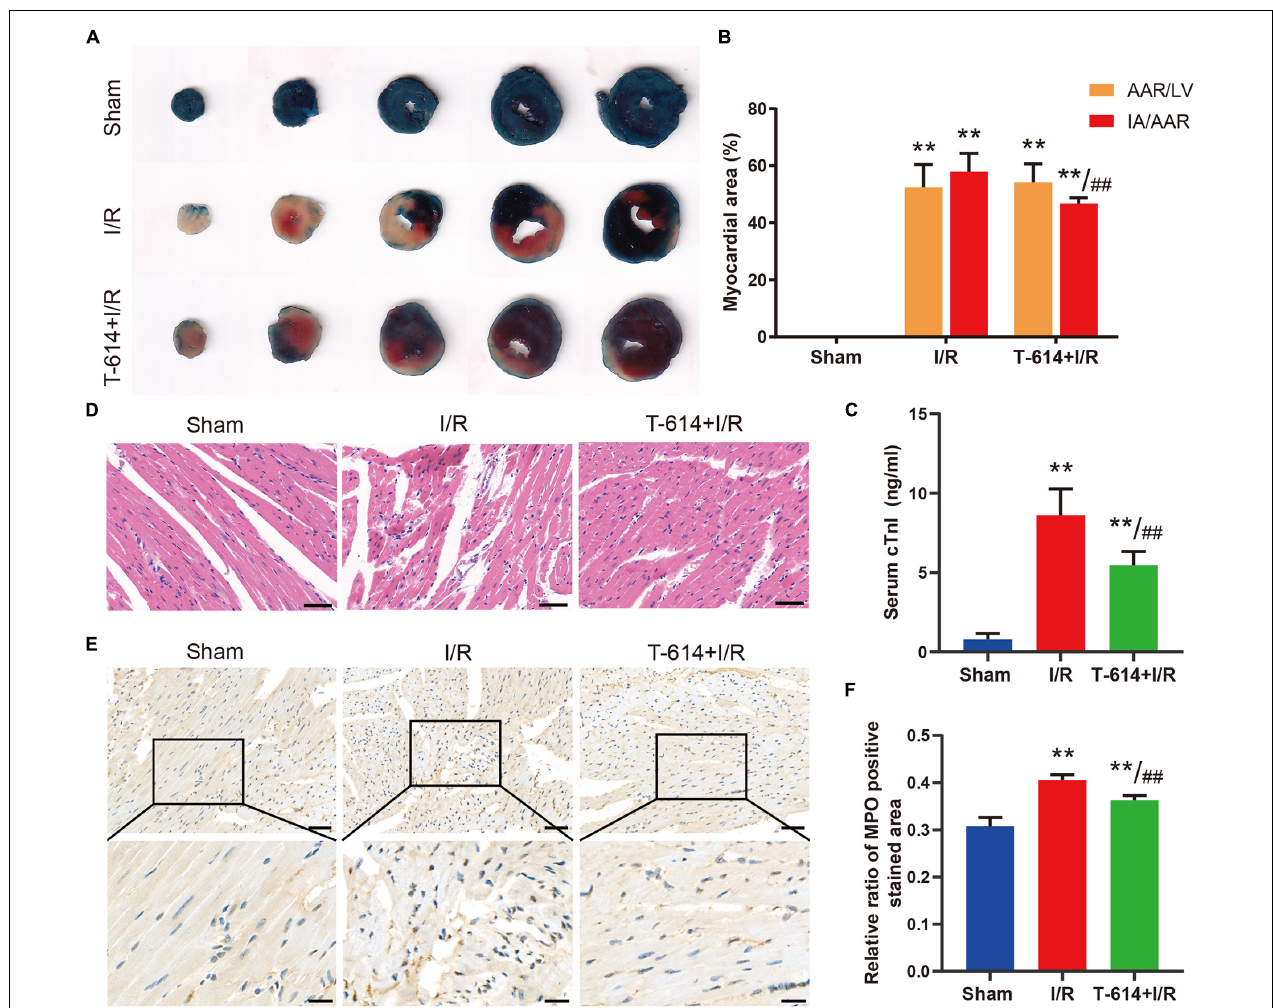
FIGURE 4 | Iguratimod ameliorated myocardial injury and infiltration of inflammatory cells after I/R. (A) Representative images of Evans blue and TTC double-stained heart sections. (B) Comparison of AAR/LV ratio and IA/AAR ratio among the three groups based on the results of A . n = 5. (C) The level of cTnI in serum determined by ELISA. n = 5. (D) Representative HE staining pictures of hearts from mice in three groups. Scale bar = 50 µ m. (E) Representative immunohistochemistry staining images of MPO in cardiac tissue. Scale bar of the first row = 50 µ m and scale bar of the second row = 20 µ m. (F) Comparison of the MPO positive stained area among the three groups. n = 4. Data are expressed as mean ± SD; ** p < 0.01 versus Sham group; ## p < 0.01 versus I/R group. I/R, ischemia/reperfusion; AAR, area at risk; LV, left ventricle; IA, infarct area; cTnI, cardiac troponin I; MPO,